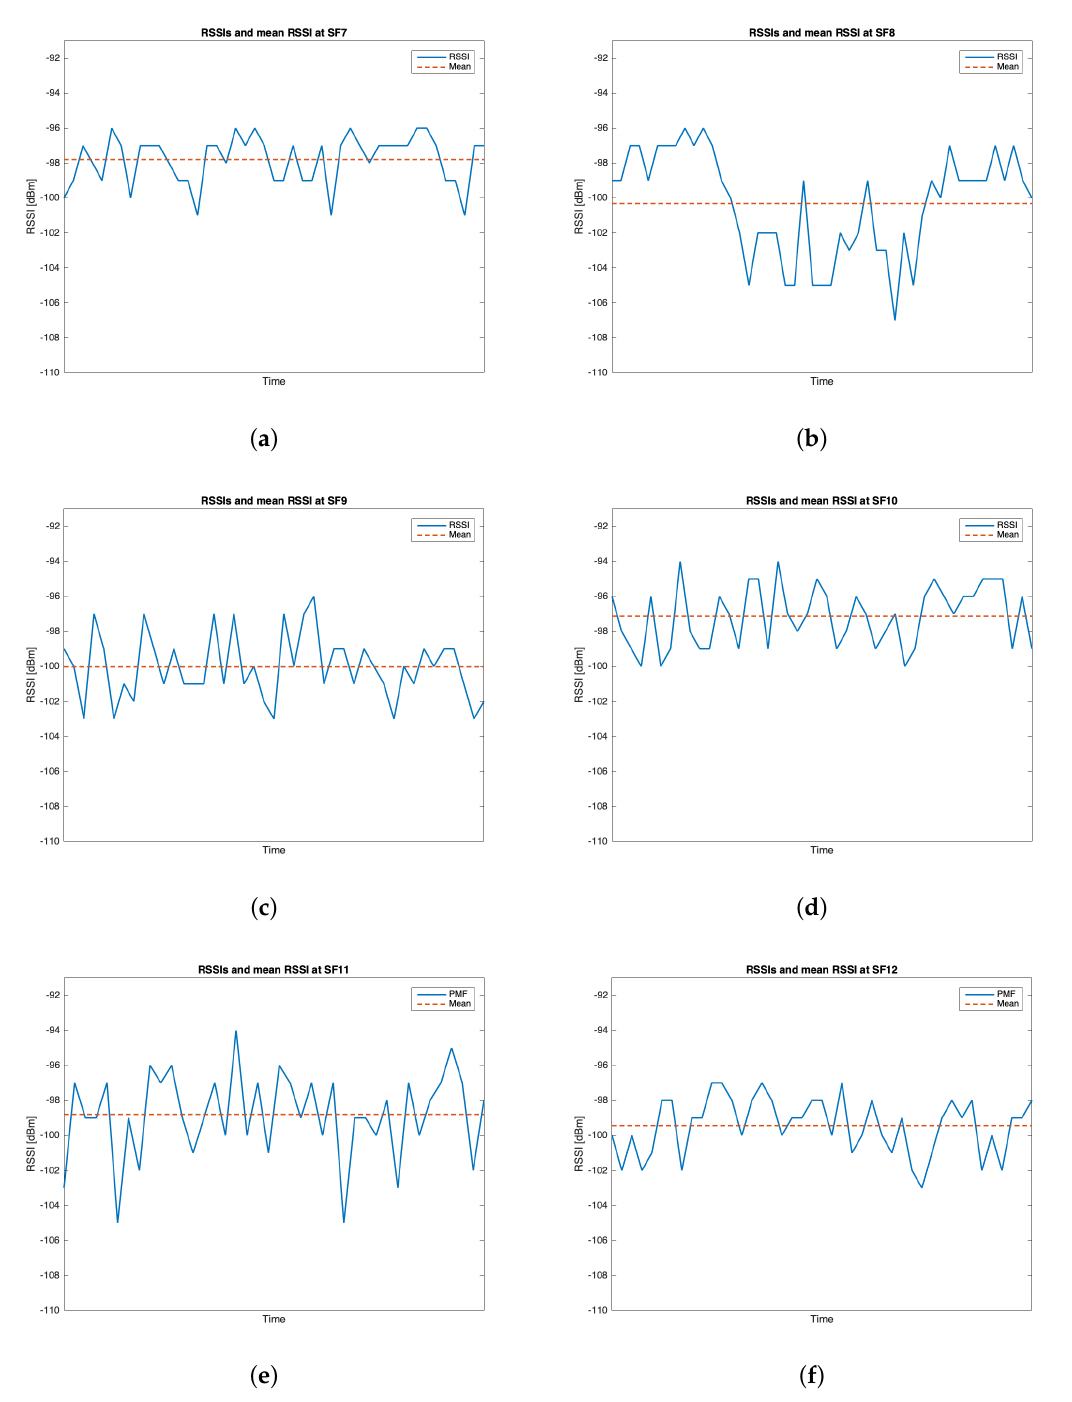
Figure 11. Group #1 RSSIs temporal trend: ( a ) SF = 7; ( b ) SF = 8; ( c ) SF = 9; ( d ) SF = 10; ( e ) SF = 11; ( f ) SF =